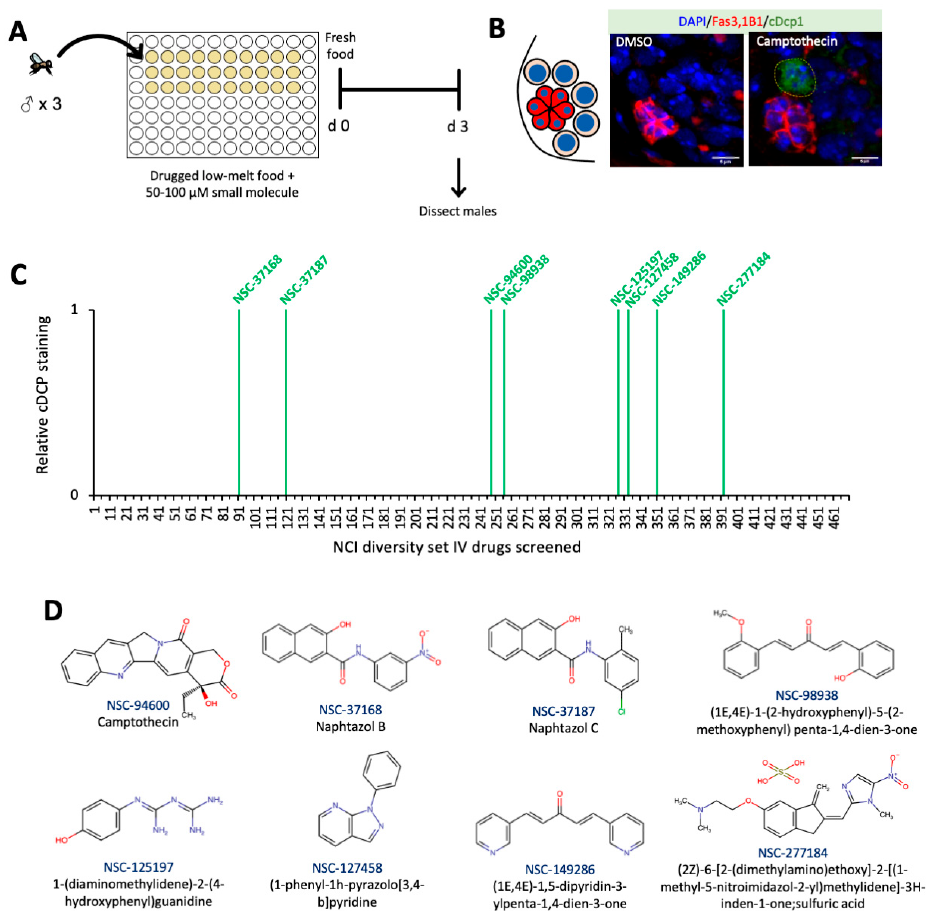
Figure 1. Primary screen for GSC apoptosis in male fruit flies fed drug-spiked solid food ( A ) Diagram of experimental set up for NCI Diversity Set IV small molecule screen in low melt agarose food in male GSCs. ( B ) Diagram of male Drosophila GSC niche, wherein 6–12 GSCs (beige) are adjacent to niche cells (red), with all cells containing nuclei (blue). Representative images of germline from males treated with either vehicle control (DMSO) or camptothecin/NSC-94600. Stained with 1B1 (spectrosome, red), FasIII (hub, red), cDcp1 (apoptosis, green), and DAPI (nuclei, blue) (Scale bar 5 µm). ( C ) Visual representation of small molecules from the NCI Diversity Set IV which cause Dcp1 cleavage in male GSCs. ( D ) Chemical structures of small molecules that potentiated apoptosis in the male GSCs in the primary drug screen.